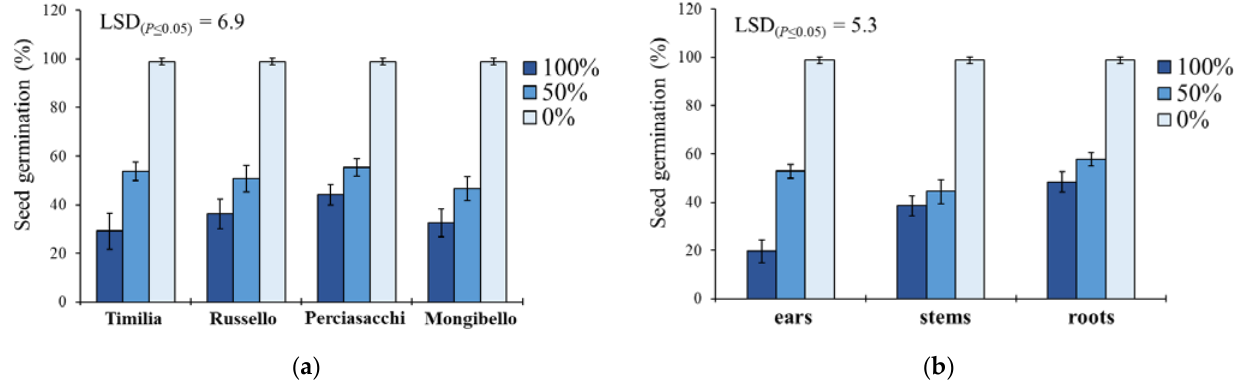
Figure 3. Effect of durum wheat ‘genotype × extract dilution’ ( a ) and ‘plant part × extract dilution’ ( b ) interactions on Stellaria media seed germination percentage. Least Significant Difference (LSD) interaction was calculated with the LSD test at p < 0.05. Bars indicate ± standard error.